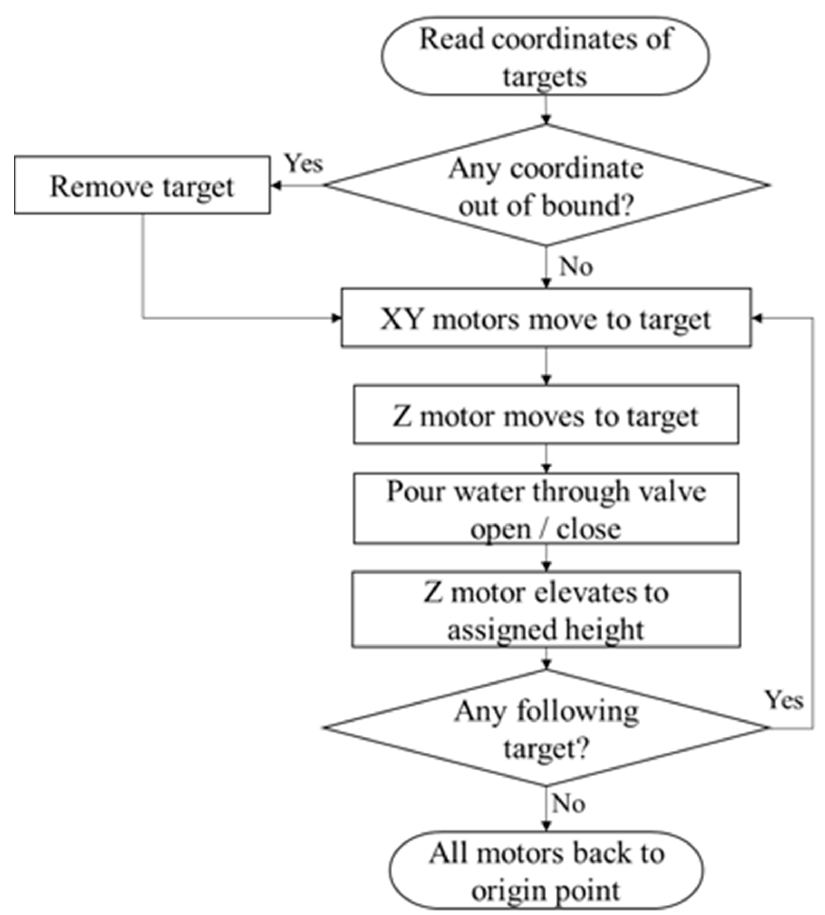
Figure 15. Flow chart of automatic watering process.